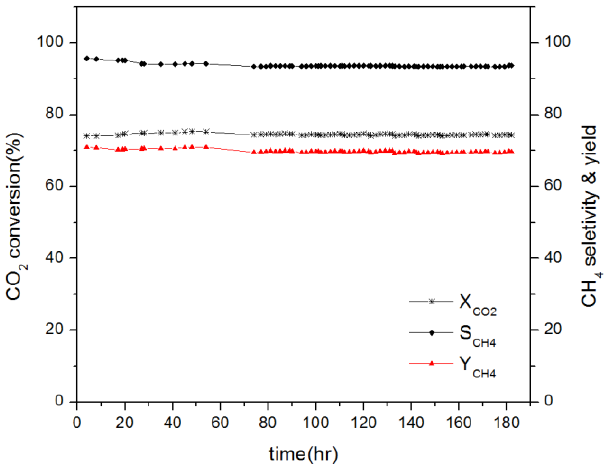
Figure 8. Stability test over 20 wt% Ni-Mg-Al catalysts.